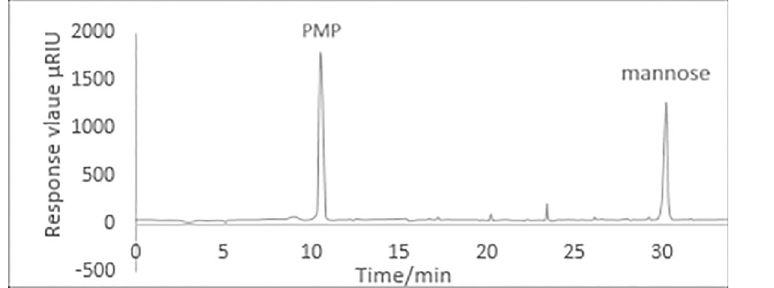
Fig 10. HPLC chromatogram of mannose.